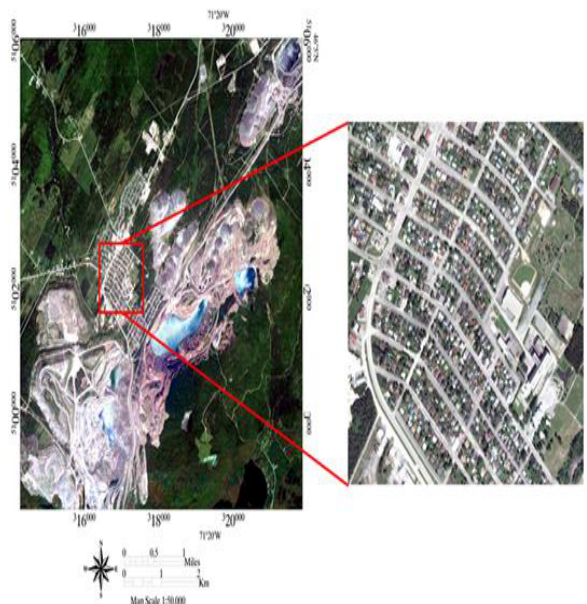
Figure 1. study area, the Thetford mines in Québec